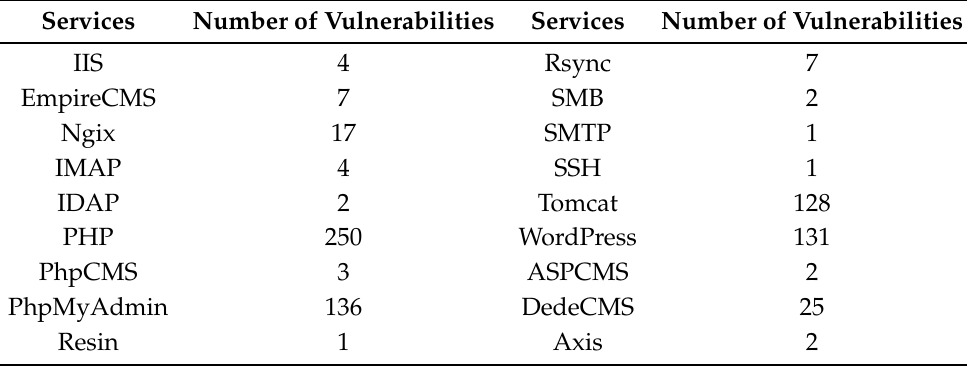
Table 17. The vulnerabilities detected by